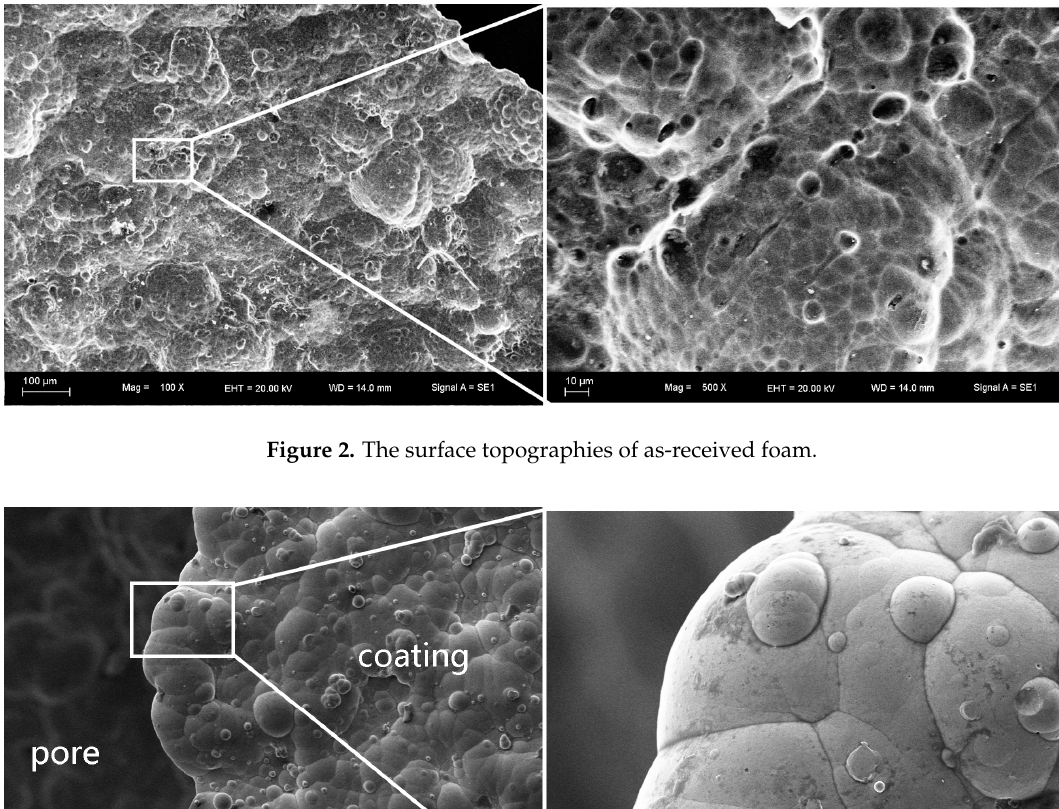
Figure 4. The cross section of electroless plating coating.